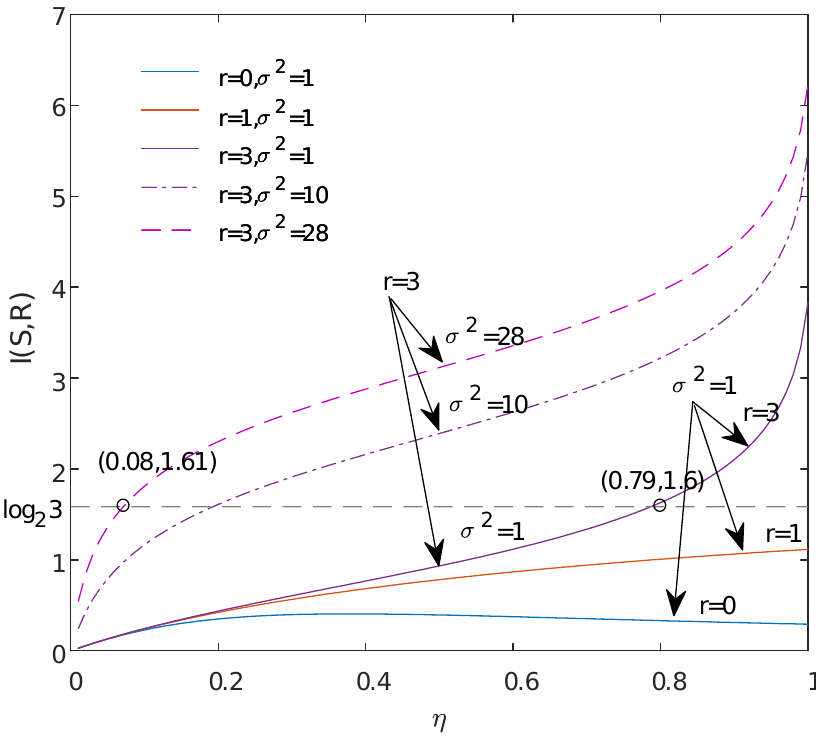
Figure 3. The information rate under different parameters ( Σ 2 = 1).